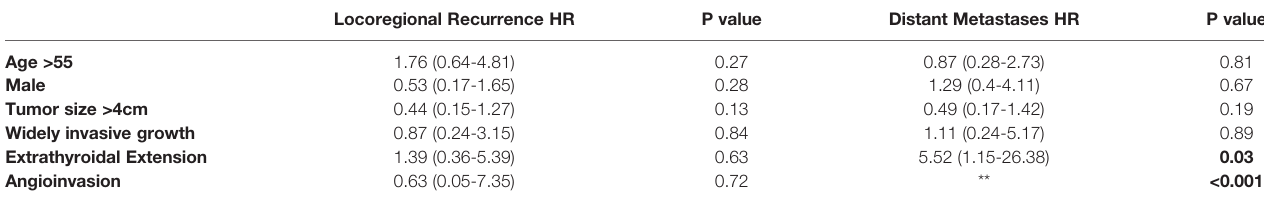
TABLE 4 | Univariate analysis of factors associated with locoregional recurrence or distant recurrence in patients with oncocytic poorly differentiated thyroid